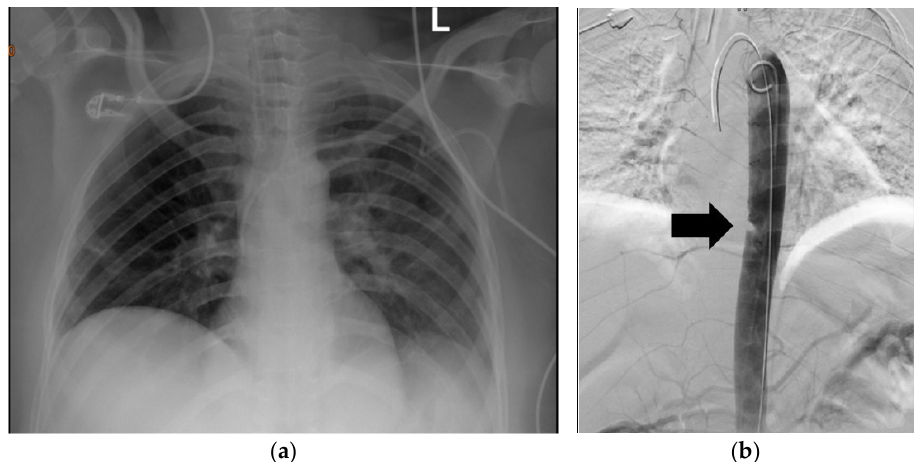
Figure 1. ( a ) Plain chest X-ray of a 40-year-old who was involved in a motor vehicle collision. The patient had fractures in ribs 4–8. ( b ) DSA demonstrating descending aortic injury. The arrow indicates a filling defect.